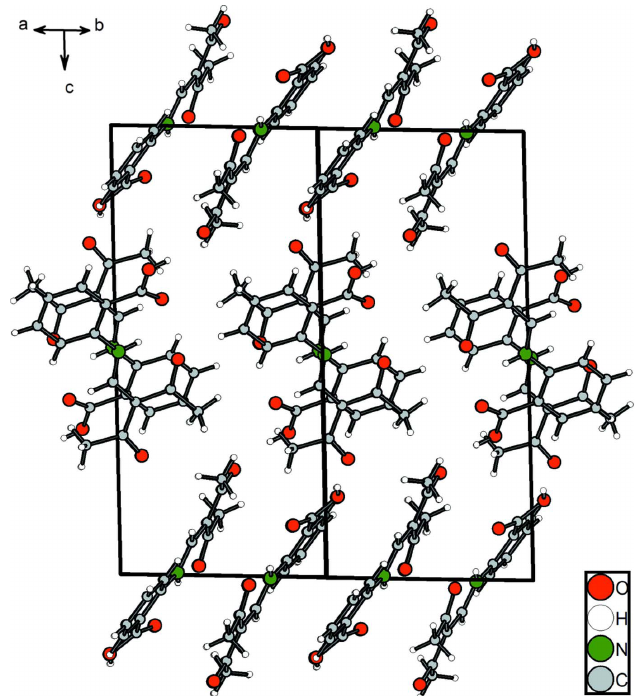
Figure 6 Molecular packing of 1 in the crystal, in a view along